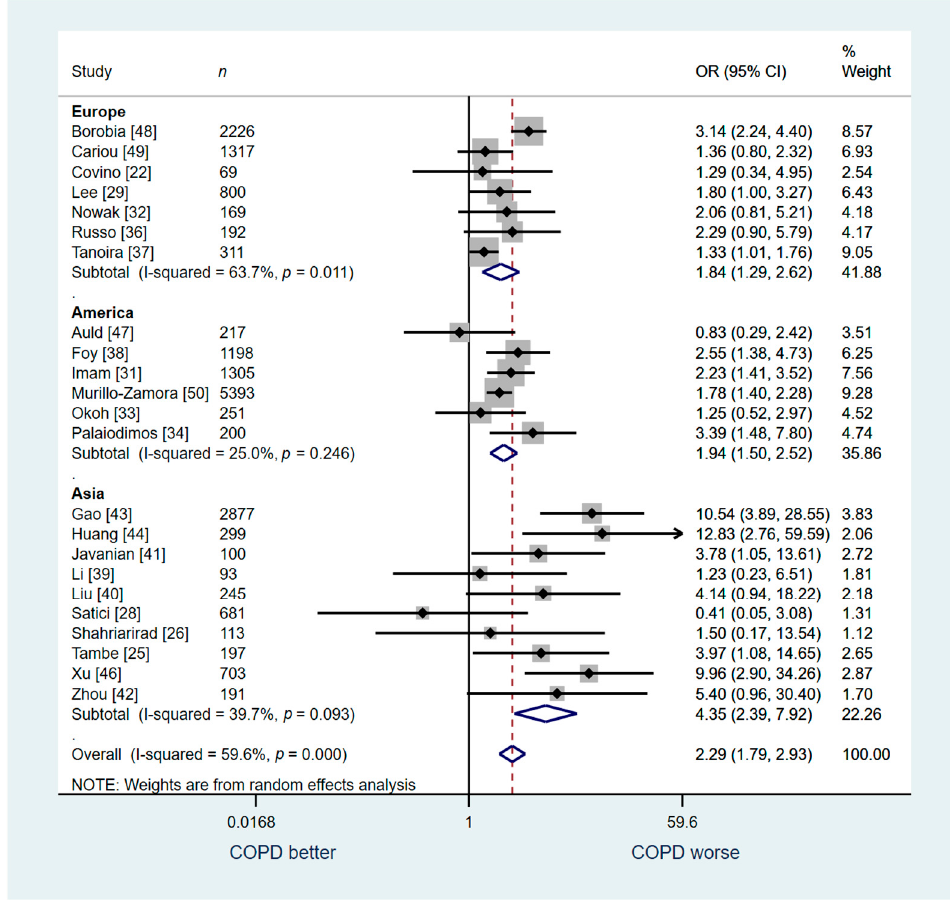
Figure 3. Overall analysis: COPD vs. no COPD for in ‐ hospital mortality.